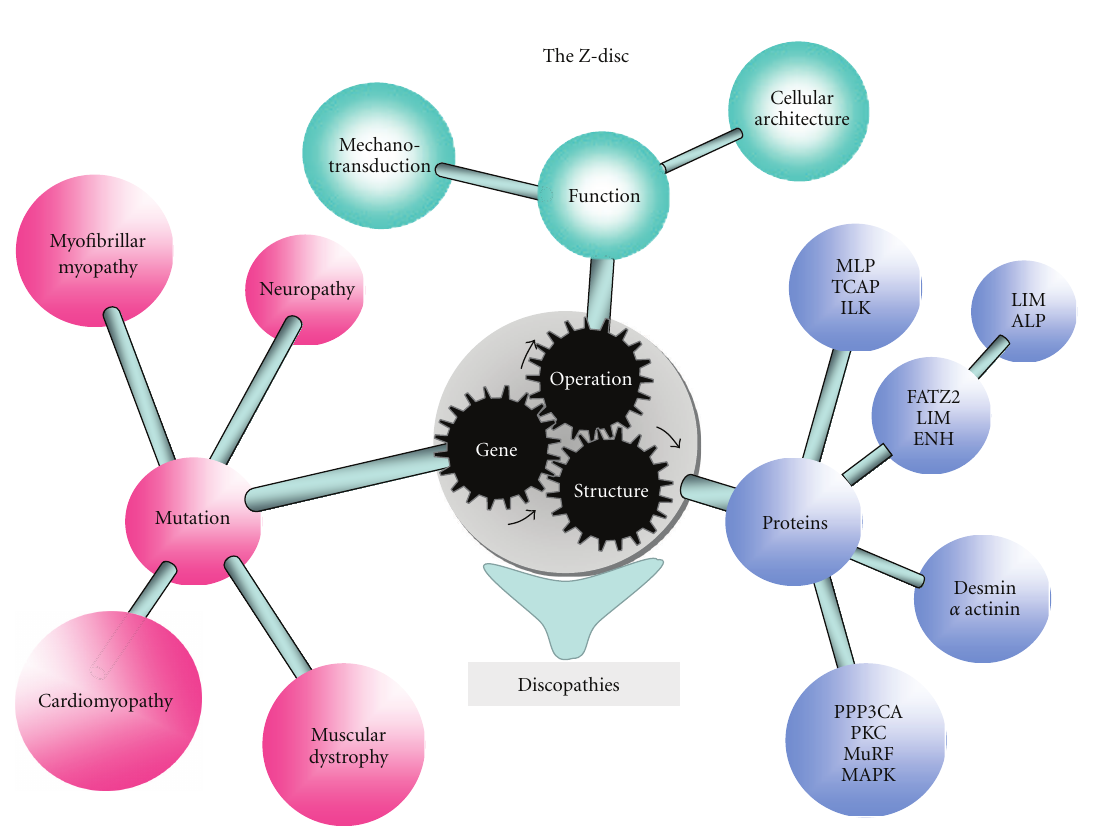
Figure 1: The sarcomeric Z-disc—multiple functions and links to maladaptation. The figure links various functions and structural aspects to maladaptation and disease, such as mutations in Z-disc proteins which are linked to di ff erent diseases. Defects in mechanosensation and mechanotransduction are linked to Z-disc mediated autophagy and UPS which in turn are linked to skeletal and cardiac muscle